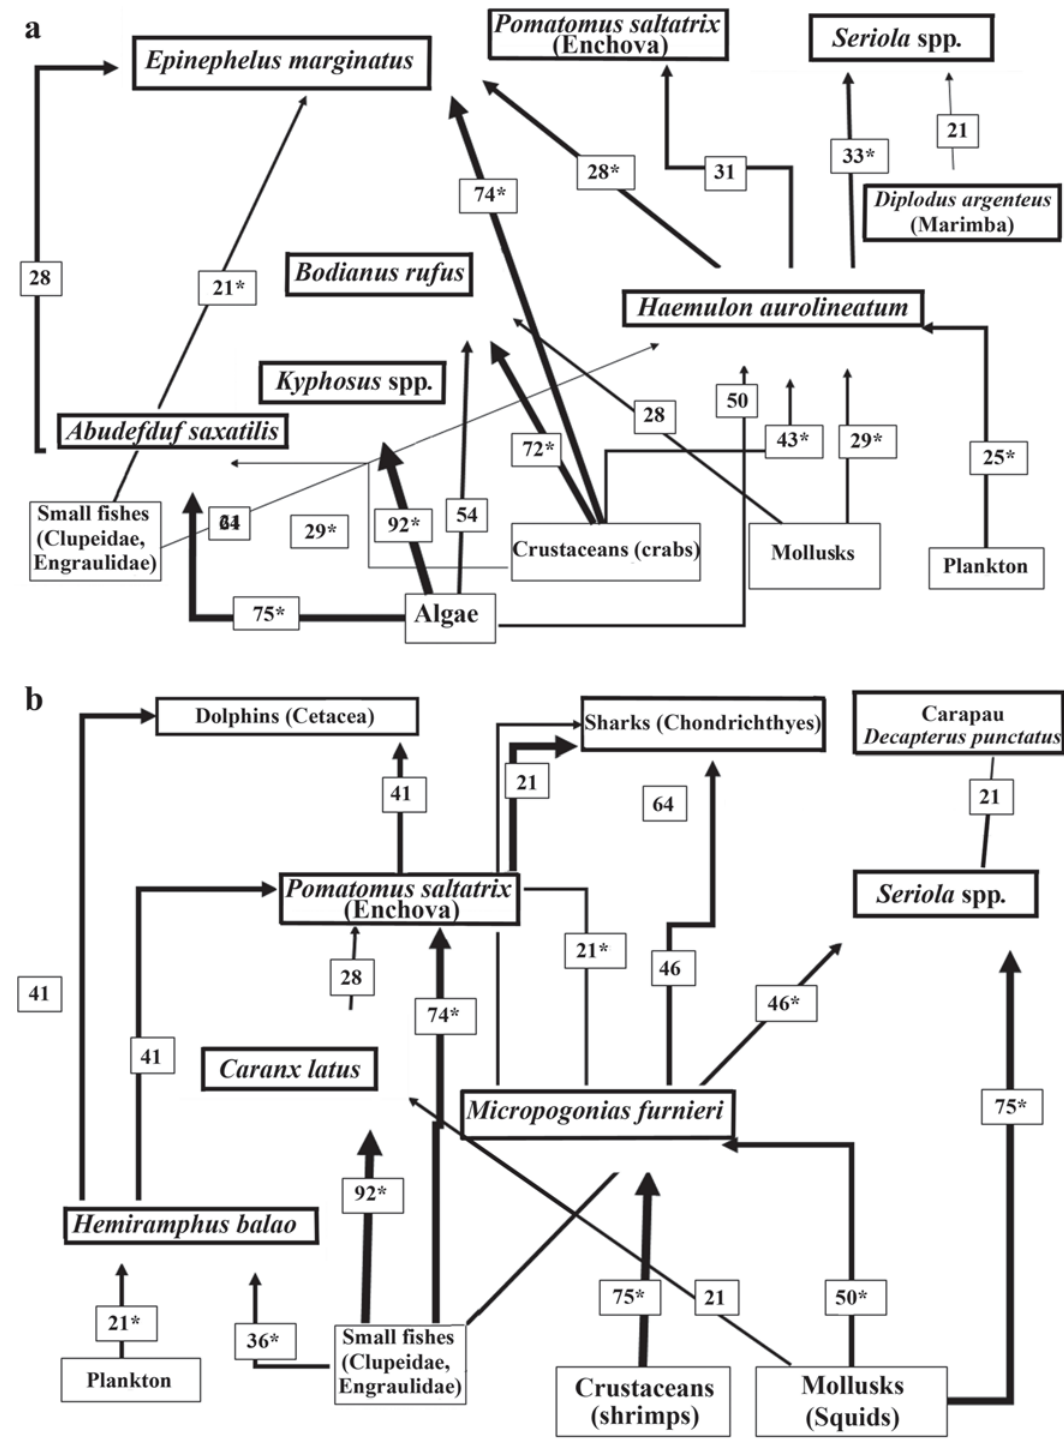
Fig. 4. Trophic chain based on those food items and predators most cited by fishermen in the southeastern Brazilian coast for a ) reef fishes and b ) pelagic fishes. Numbers are percent of interviewed fishermen who mentioned each feeding interaction. Fish sizes are not in scale. Those feeding interactions that agree with reported feeding habits of these fishes in the biological literature are marked *(Randall, 1967; Berkeley & Houde, 1978; Menezes & Figueiredo, 1980; Sazima, 1986; Pipitone & Andaloro, 1995; Barreiros & Santos, 1998; Vasconcellos & Gasalla, 2001; Silvano, 2001; Silvano & Güth, 2006; Figueiredo & Vieira, 2005; Gibran,